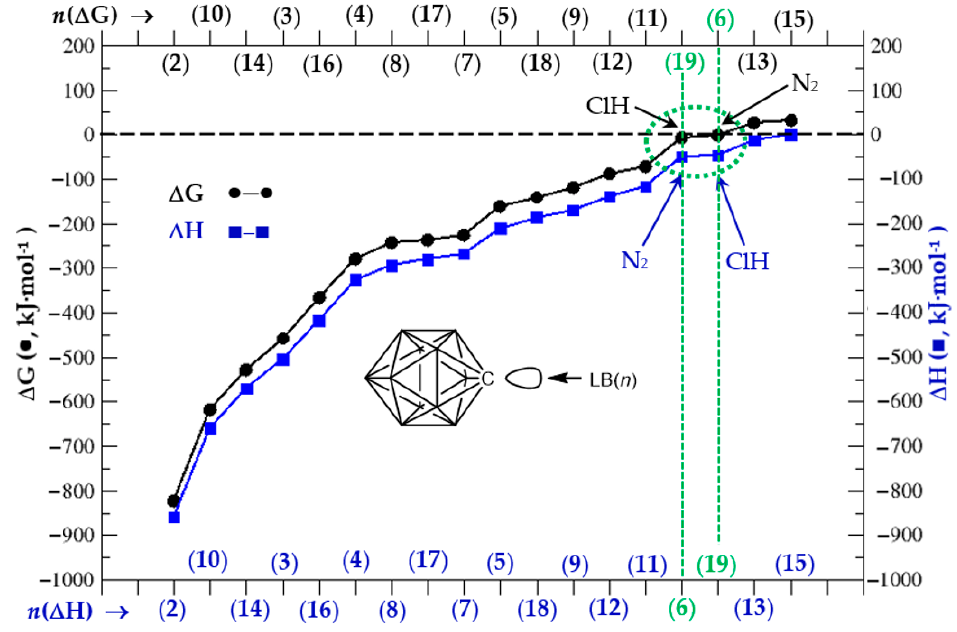
Figure 4. ∆ G and ∆ H vs. Lewis base n in respective increasing order, all in kJ · mol − 1 Figure 4. Δ G and Δ H vs. Lewis base n in respective increasing order, all in kJ·mol − 1 .